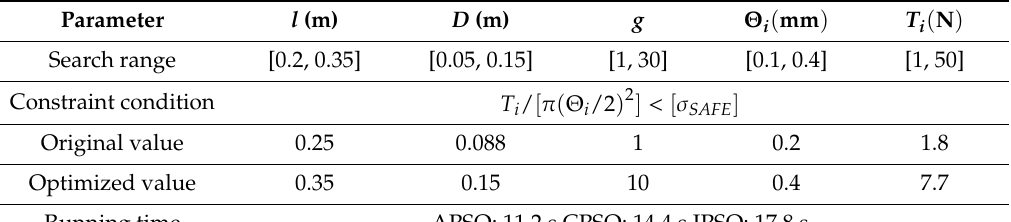
Table 5. Parameter information used in Figure